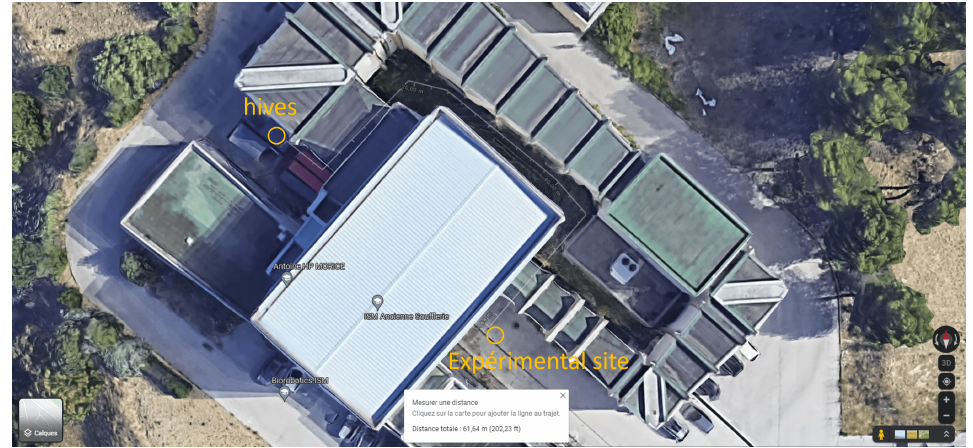
Figure 4. Geolocaltion of hives (43°14 (cid:48) 02.9 (cid:48)(cid:48) N 5°26 (cid:48) 37.3 (cid:48)(cid:48) E) and experimental site in the Parc National des Calanques, Marseilles, France. Both are separated by a 60 m path, and bees pass through it in at least 3